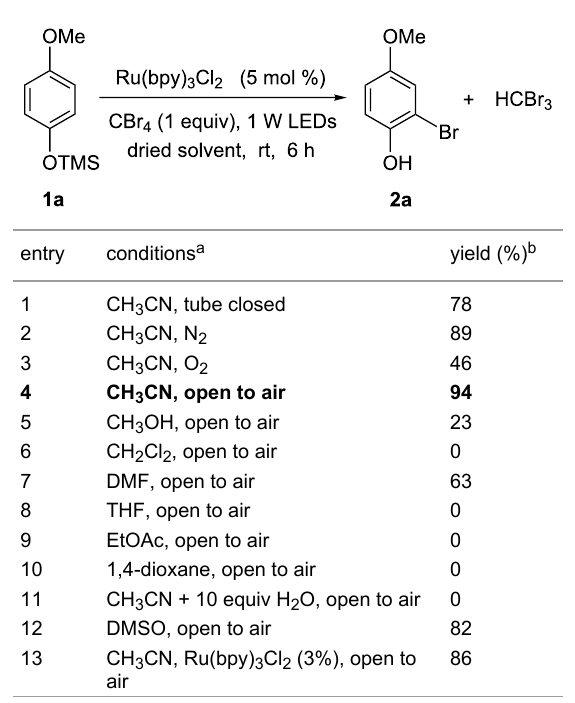
Table 1: Survey of the photocatalytic bromination reaction